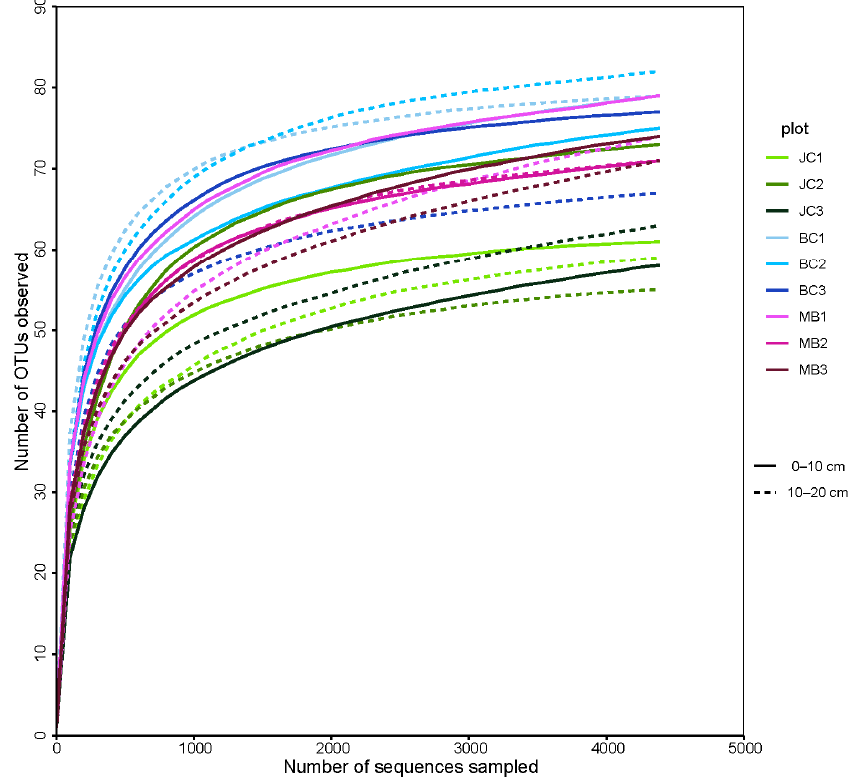
Figure 1. The rarefaction curves for OTUs-sequences. Note: JC, BC, and MB indicate Japanese cedar, bamboo-cedar mixed, and moso bamboo forest, respectively.